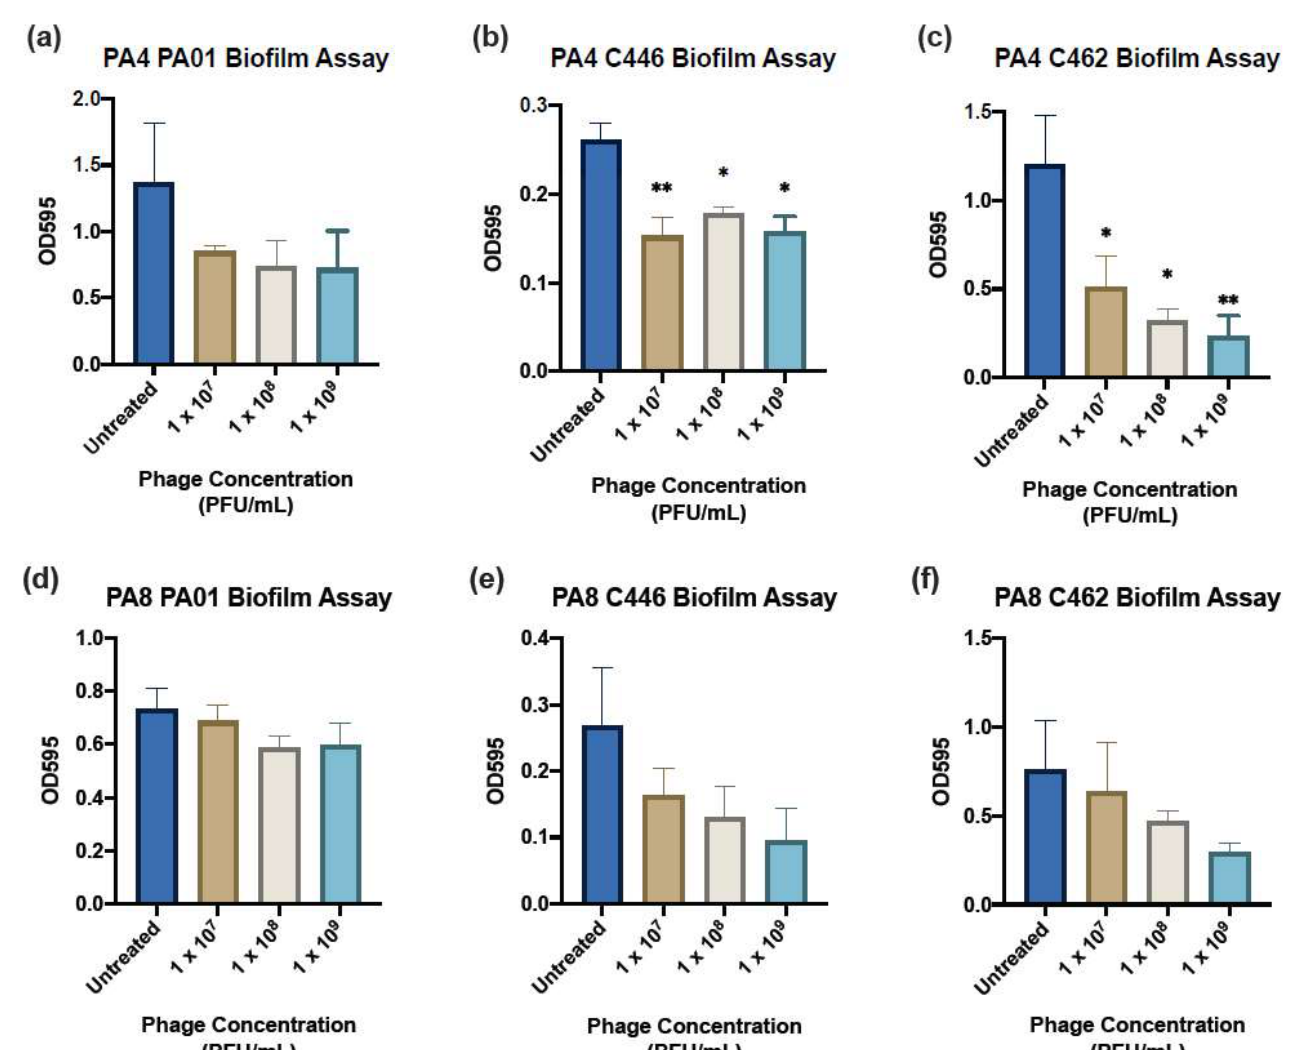
Figure 4. Biofilm Assays. Biomass of biofilms as measured by absorbance at 595 nm of crystal violet-stained biofilms after 24 h of treatment with PA4 ( a – c ) and PA8 ( d – f ) at three different concentrations (1 × 10 7 , 1 × 10 8 , 1 × 10 9 PFU mL − 1 ) with significance determined compared to the untreated control. Data expressed as mean ± SEM for three independent experiments. *, p < 0.05; **, p < 0.01 .